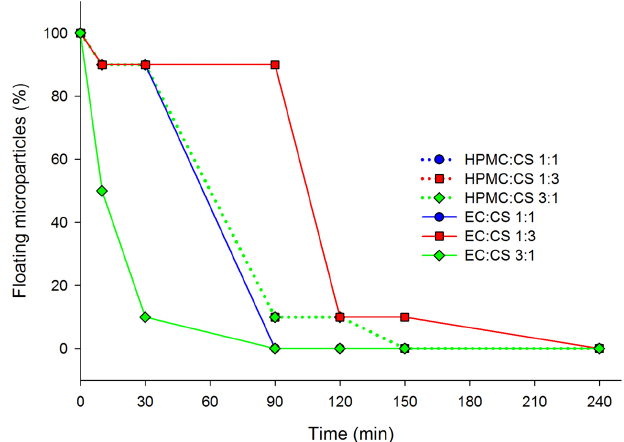
FIGURE 5 - Floating ability of microparticles. CS: chitosan; HPMC: hydroxypropyl methylcellulose; EC: